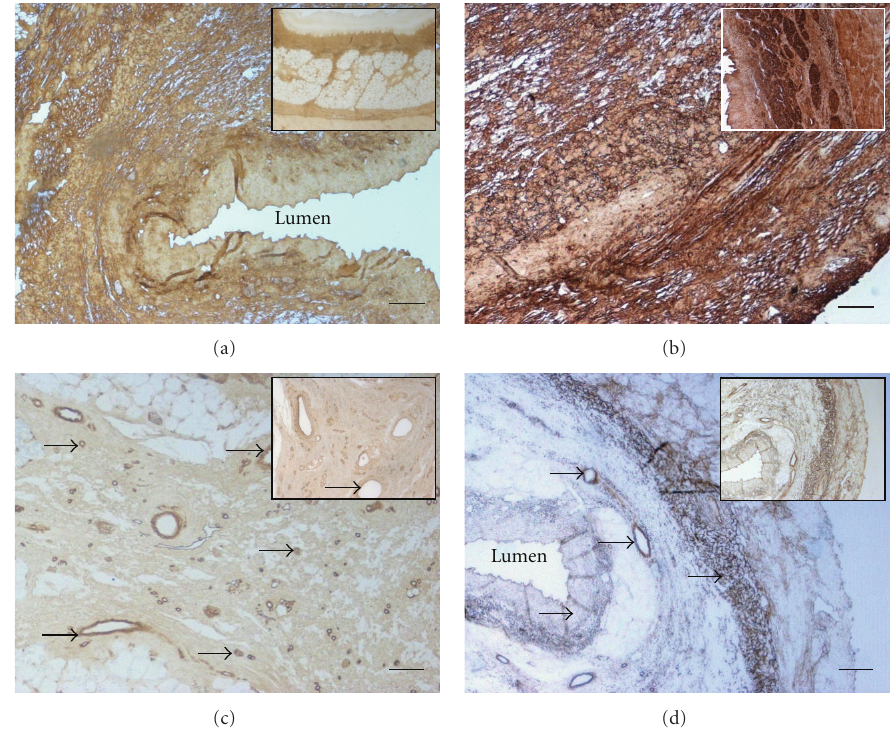
Figure 2: Immunohistochemical DAB staining (brown staining) of decellularized porcine esophagus tissue for collagen III (a), fibronectin (b), collagen IV (c), and elastin (d) in comparison to natural esophagus (small pictures). The arrow heads mark vessels. Decellularized esophagus sca ff olds were shown to maintain native extracellular matrix composition. Original magnification: x40 (a and d) and x100 (b and c); bar = 100 μ m.